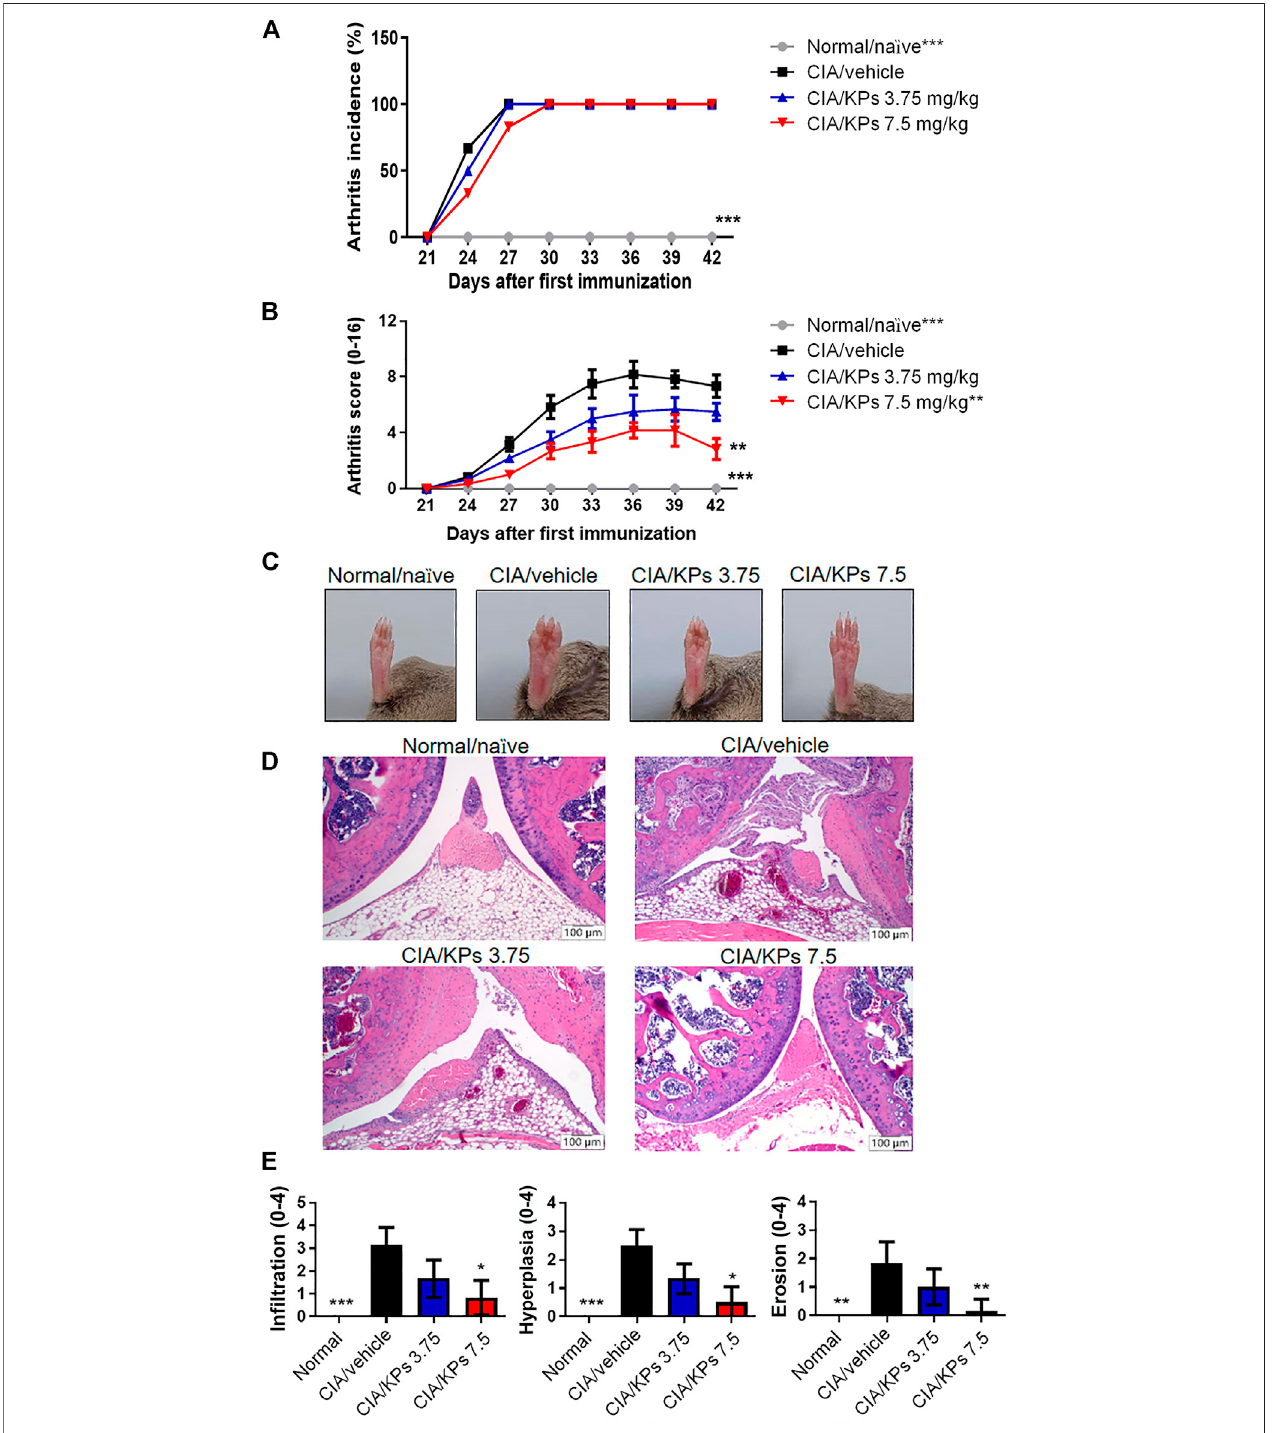
FIGURE 3 | Effects of KPs on type II CIA severity. The arthritis incidence (A) and arthritis score (B) were observed every 3 days after type II collagen (CII) booster immunization (day 21). (C) The whole view of the severity of arthritis in the right legs of the mice. Characterization of paw swelling, erythema, edema, and joint rigidity in groups subjected to different treatment. (D) Representative photographs of histopathological examination by H&E staining (100 × magni fi cation) on day 42. (E) PathogenicscoresofCIAweredetermined.Thedataarepresentedasthemean ± SEM(n (cid:1) 5).* p < 0.05;** p < 0.01;*** p < 0.001vstheCIA/vehiclecontrolgroup, as determined by two-way ANOVA ( A , B ) or one-way ANOVA with Dunnett ’ s test (E) .